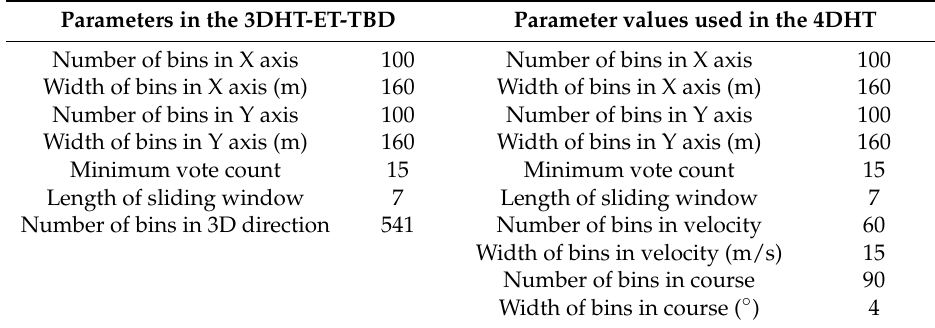
Table A4. Parameter values used for simulations and real data.